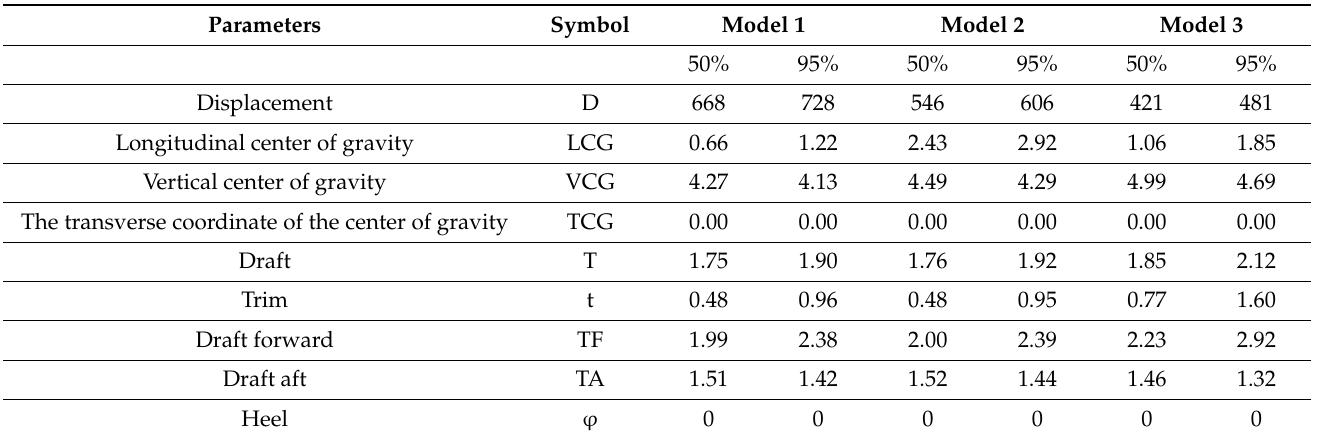
Table 5. Parameters of vessels after symmetrical flooding of